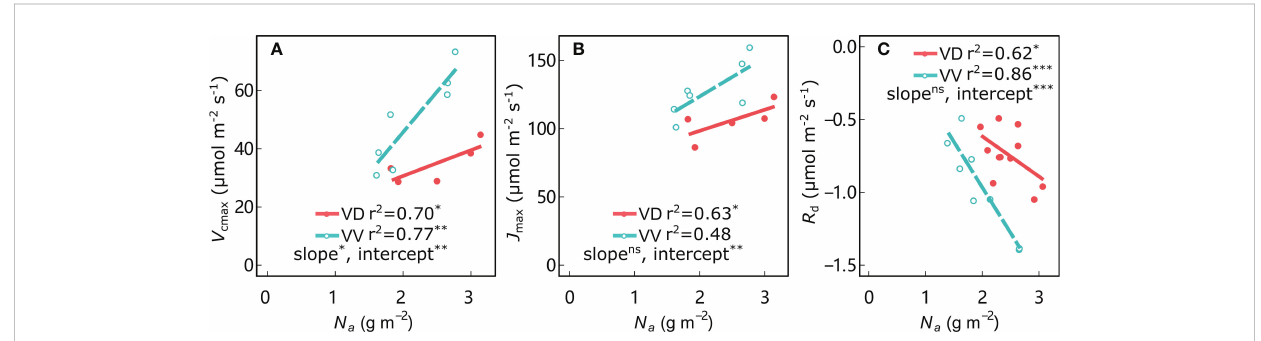
FIGURE 5 Relationships between maximum rates of carboxylation ( V cmax ) (A) , maximum rates of electron transport ( J max ) (B) , and dark respiration ( R d ) (C) with leaf nitrogen content per area ( N a ) for ‘ Gala ’ apple trees grafted on vigorous rootstocks associated with either a dwarf M26 interstock (VD) or a vigorous ‘ Qinguan ’ interstock (VV). Linear regression coef fi cients (r2) and signi fi cance and interstock effects on slopes and intercepts are shown by the level of signi fi cance of the p-values: *signi fi cant at 0.01 ≤ P< 0.05; **signi fi cant at 0.001 ≤ P< 0.01; ***signi fi cant at P< 0.001 and no signi fi cant difference with ns.